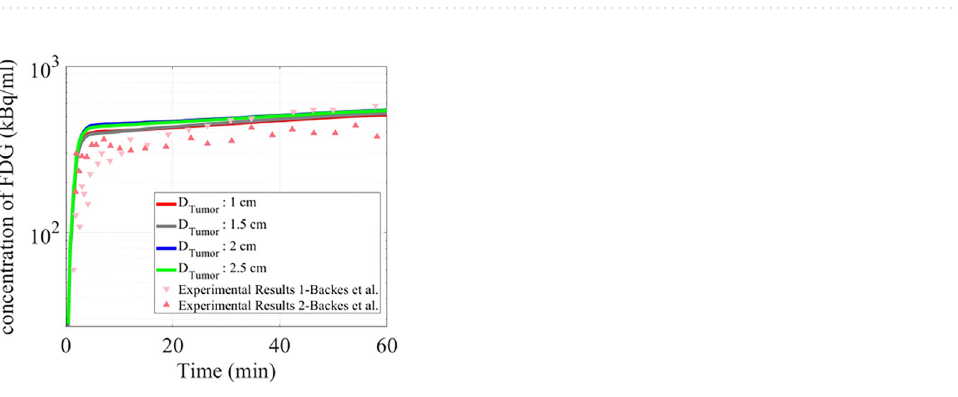
Figure 2. Flowchart used to step-by-step description of radiopharmaceutical transport modeling in solid tumors.